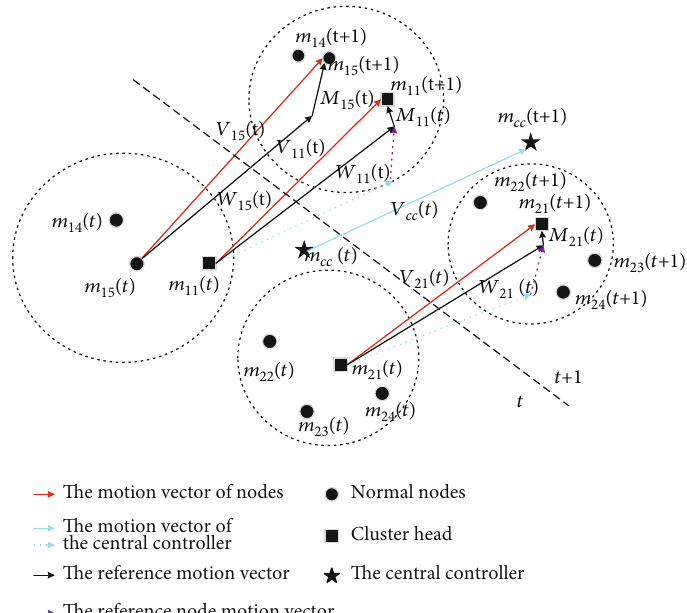
Figure 8: Schematic diagram of the ML-RNGM model.